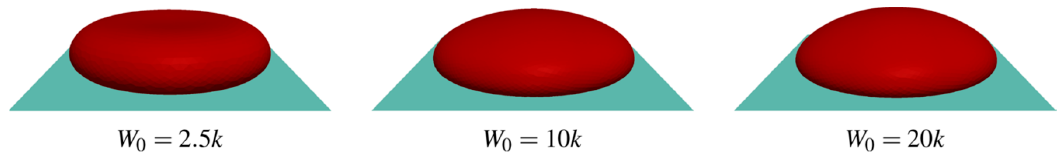
Figure 13. The computed shape of the RBC in contact with a plane for different adhesion intensities (adapted from [191] with permission).